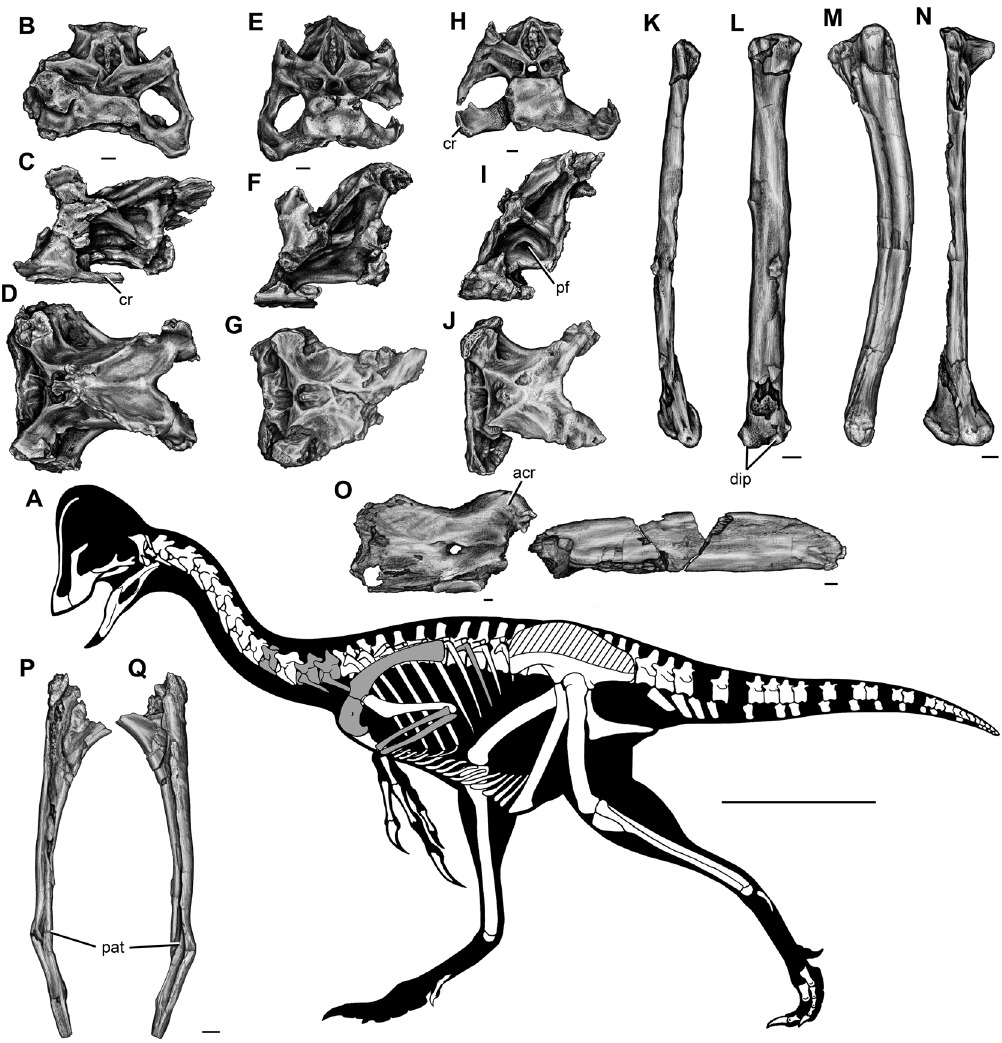
Figure 5. MRF 319, a partial oviraptorosaurian skeleton referred to Anzuwyliei gen. et sp. nov. ( A ) Skeletal reconstruction in left lateral view, with preserved bones in gray and bones represented in other Anzu specimens in white (hatching indicates heavily reconstructed portions of the ilia of CM 78001). Middle-posterior (ninth?) cervical vertebra in ( B ) anterior, ( C ) left lateral, and ( D ) dorsal views. Posterior (11 th ?) cervical vertebra in ( E ) anterior, ( F ) left lateral, and ( G ) dorsal views. Posterior (12 th ?) cervical vertebra in ( H ) anterior, ( I ) left lateral, and ( J ) dorsal views. Anteroposteriorly crushed left radius in lateral ( K ) and anterior ( L ) views. Mediolaterally crushed left ulna in lateral ( M ) and anterior ( N ) views. ( O ) Partial left scapulocoracoid in lateral view. Dorsal rib in anterior ( P ) and posterior ( Q ) views. Abbreviations: acr, acromial process; cr, cervical rib; dip, distal processes; pat, pathology; pf, pneumatic fossa. Scale bars =50 cm in A; 1 cm in B–Q.